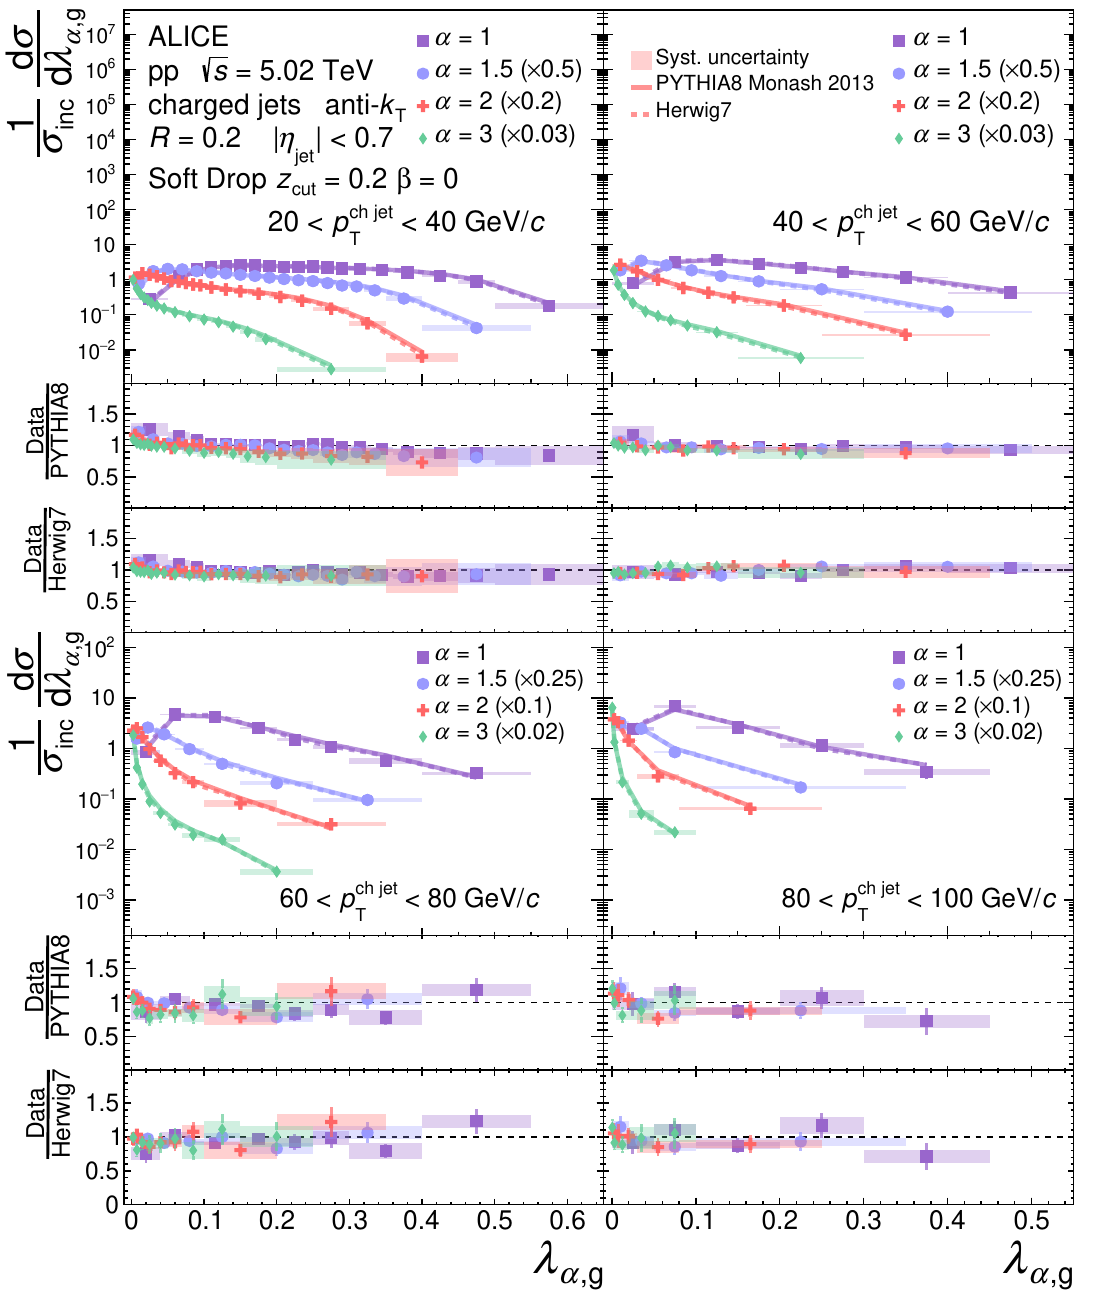
Figure 4 . Comparison of groomed jet angularities λ α, g in pp collisions for R = 0 . 2 to MC predictions using PYTHIA8 and Herwig7, as described in the text. Four equally-sized p ch jet between 20 and 100 GeV /c . The distributions are normalized to the groomed jet tagging